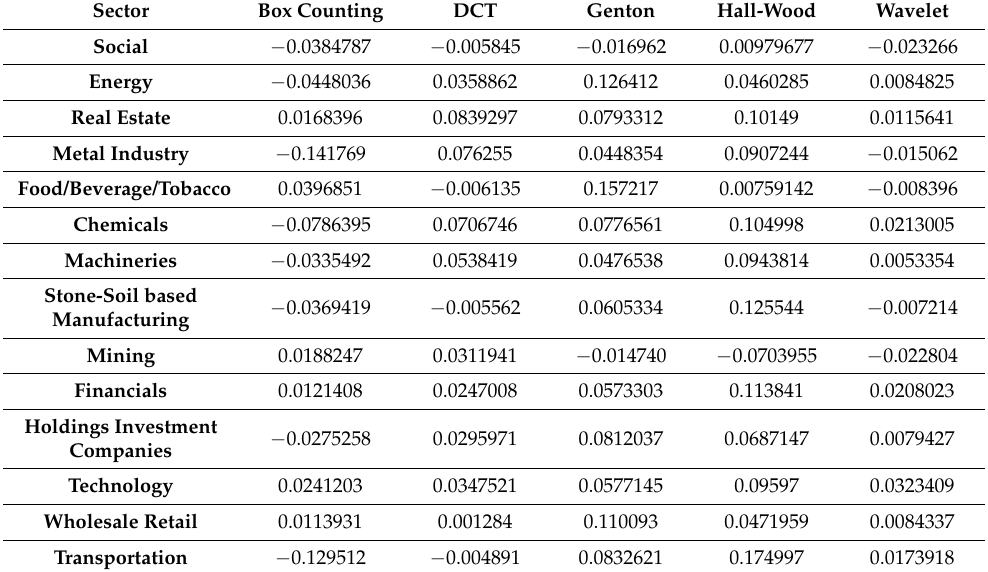
Table 1. Percentage average changes for each